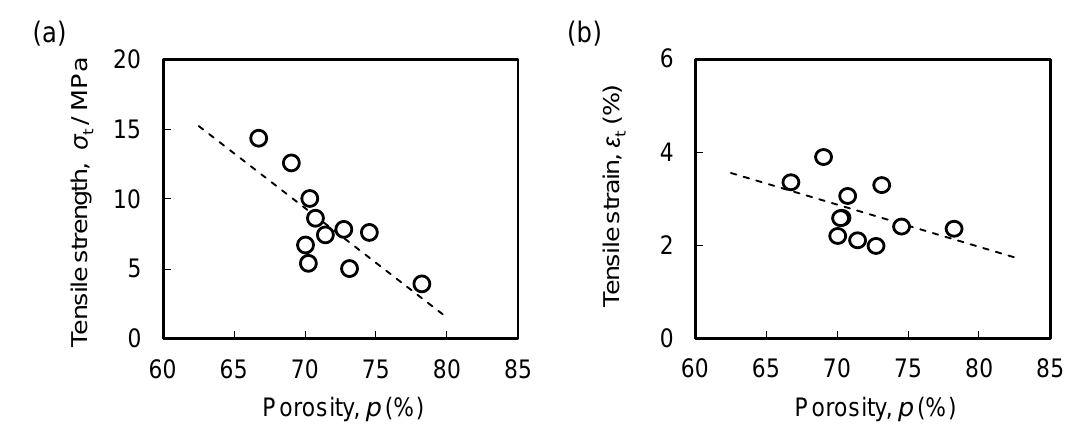
Figure 4. Tensile properties of ADC12 foams. ( a ) Relationship between porosity of the ADC12 foams and tensile strength σ ; ( b ) Relationship between porosity of the ADC12 t foams and tensile strain ε . t